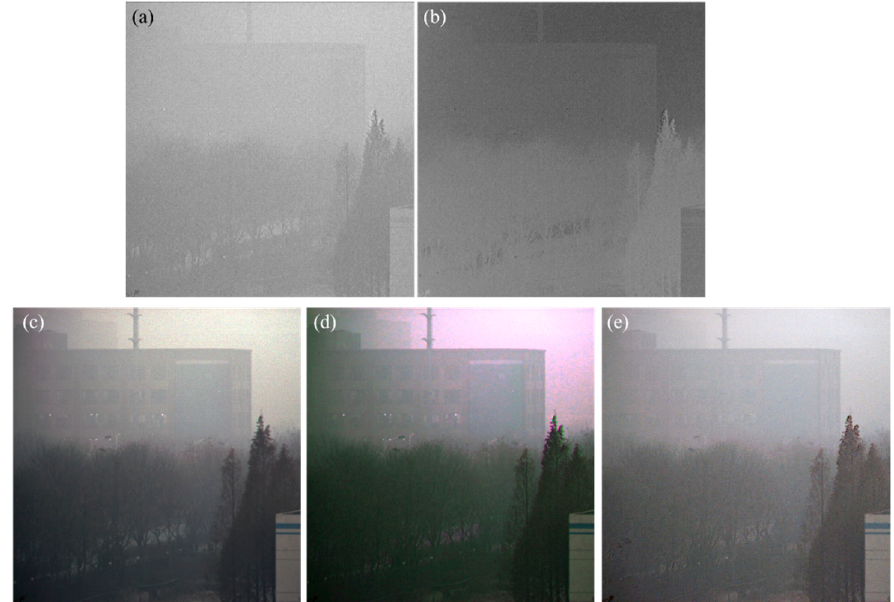
Figure 4. ( a ) The map of A ; ( b ) the transmittance of atmosphere; ( c ) the dehazed image using our proposed polarimetric dehazing method; ( d ) the dehazed image using the dehazing method proposed in [12] ; ( e ) the dehazed image using the dehazing method proposed by Y. Schechner [24].